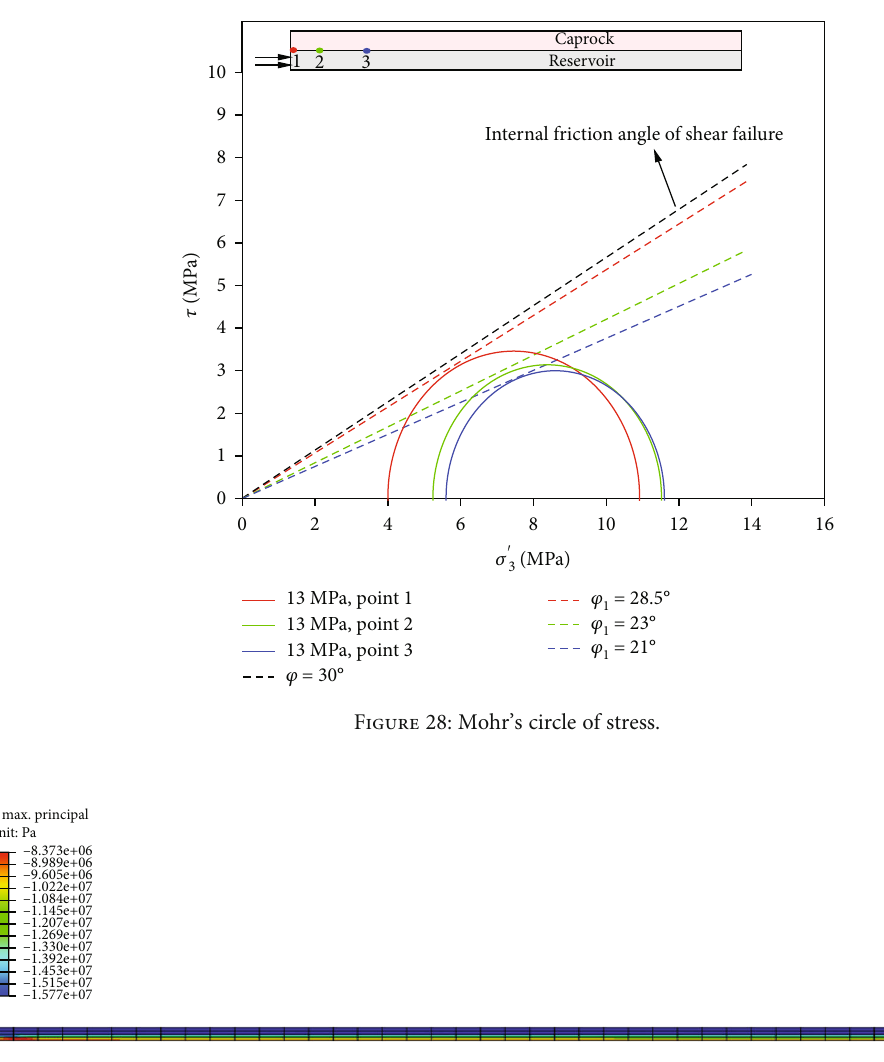
Figure 29: The minimum principal stress nephogram of caprock.